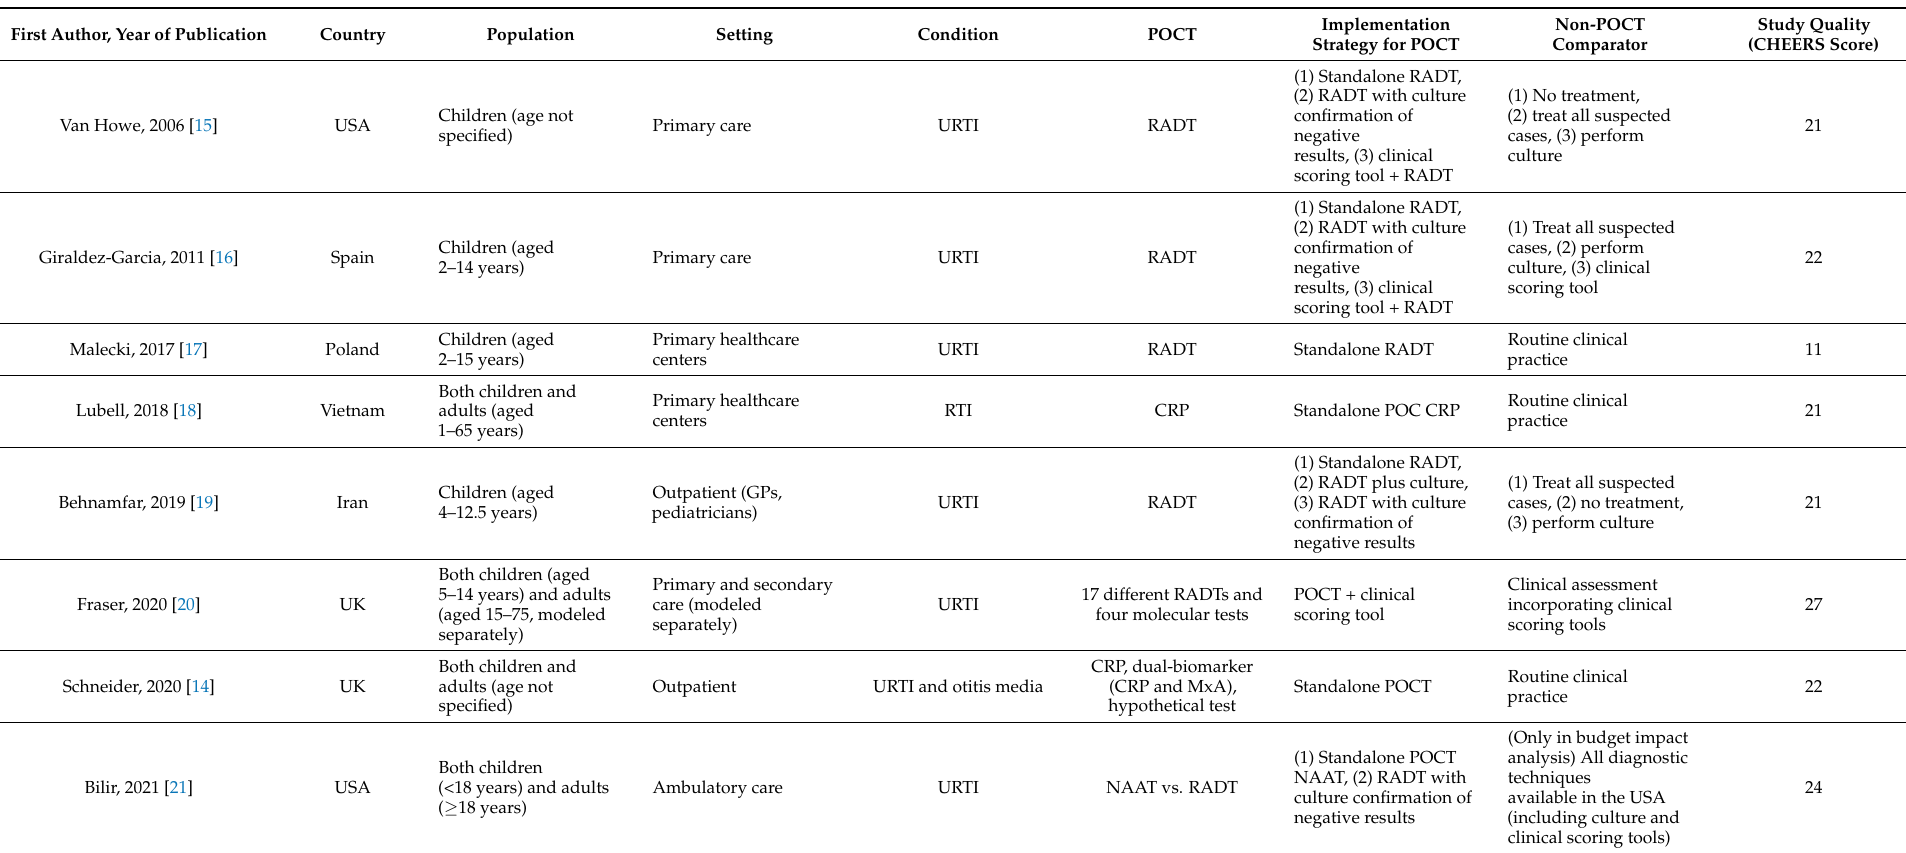
Table 1. Characteristics of studies reporting economic evaluations of antimicrobial stewardship strategies including point-of-care testing in pediatric patients with respiratory-tract